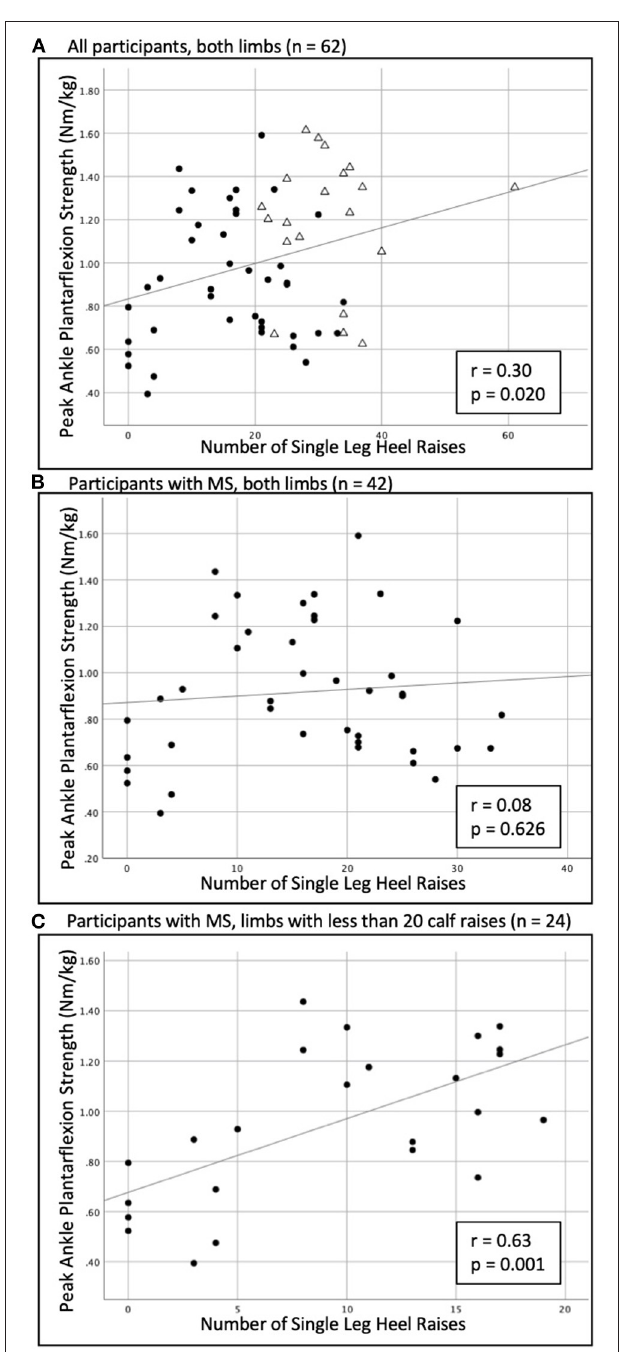
FIGURE 1 | Relationship of the single-leg heel raise test to plantarflexion isometric strength in (A) the overall sample ( n = 62), (B) the MS group only ( n = 42), and (C) considering any limb that completed < 20 heel raises ( n = 24). • = participants with MS; △ = healthy control.